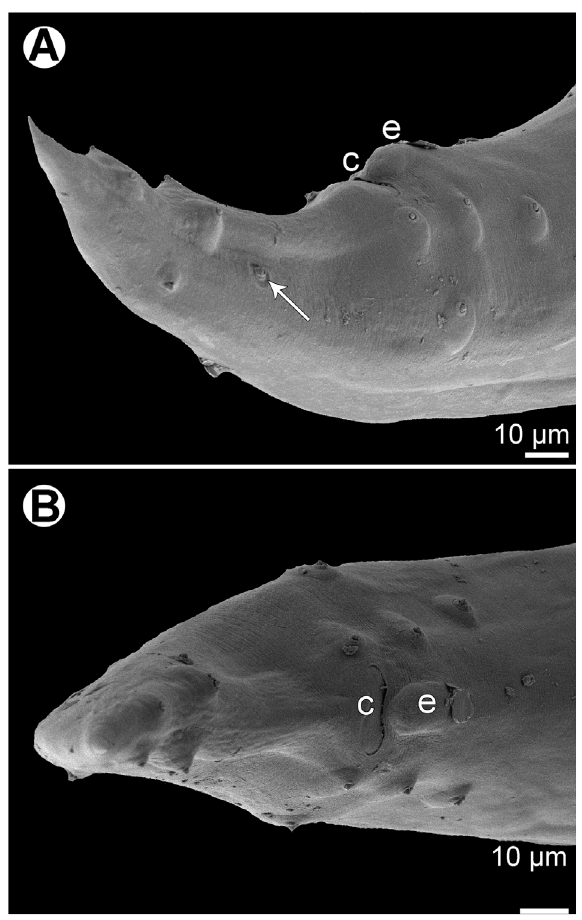
Figure 6. Cucullanus acutospiculatus n. sp. from Caesio cuning , scanning electron micrographs of male tail (another